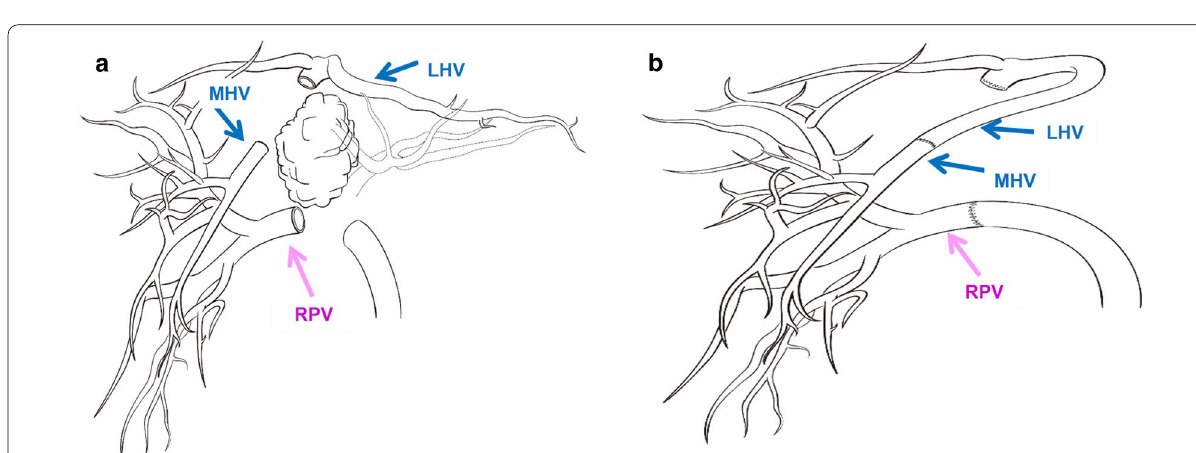
Fig. 6 Schematic diagram of the operation: a shows the location to remove MHV and RPV. b Shows the way to reconstruct MHV and RPV. The left hepatic vein was used for reconstruction of the middle hepatic vein, because it was far away from the tumor which ensured the R0 resection of the tumor and the entirety of hepatic blood inflow and outflow. MHV middle hepatic vein, LHV left hepatic vein, RPV right portal